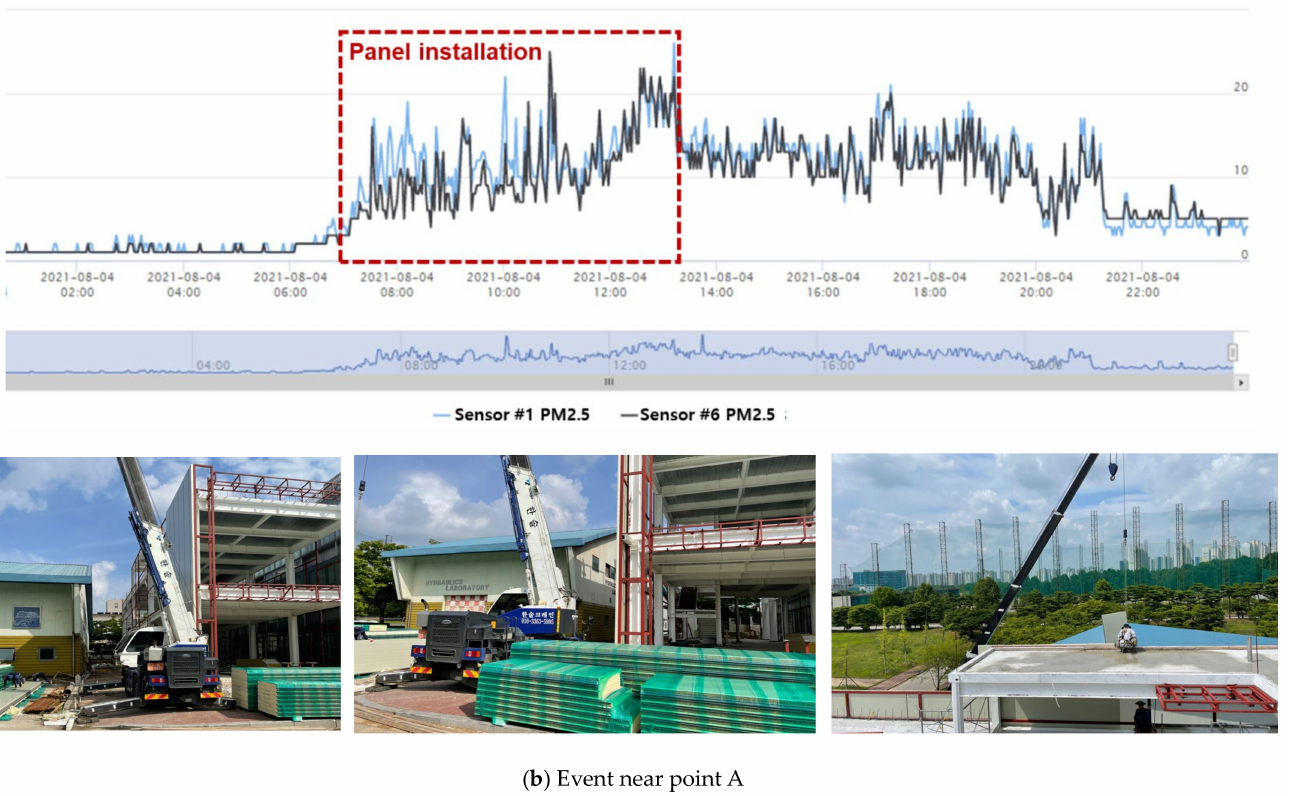
Figure 10. Dust generating events (4